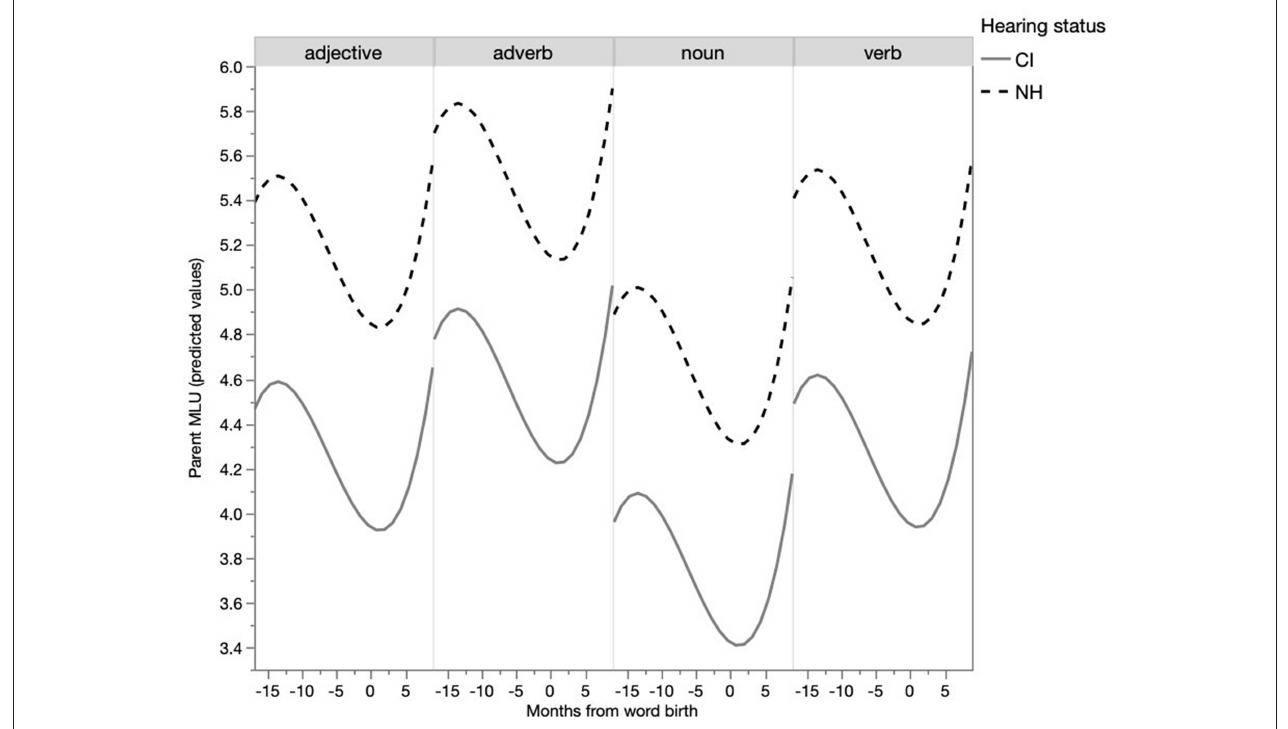
FIGURE 4 | Development of parent MLU per word class (predicted